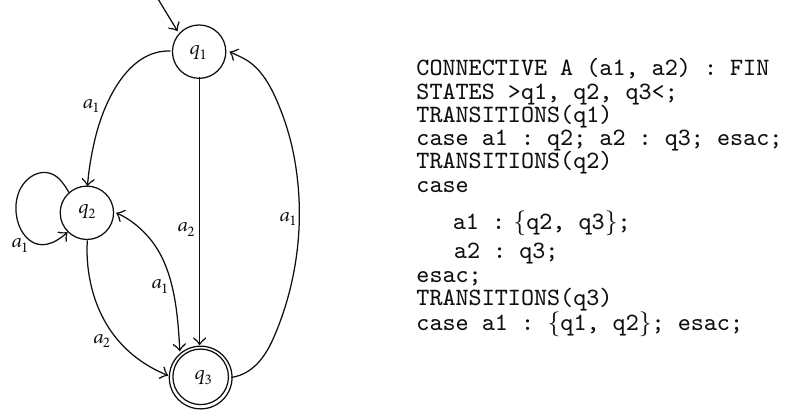
Figure 1: An automata connective declaration in ENuSMV. Table 1: Comparative results of BDD-based and BMC